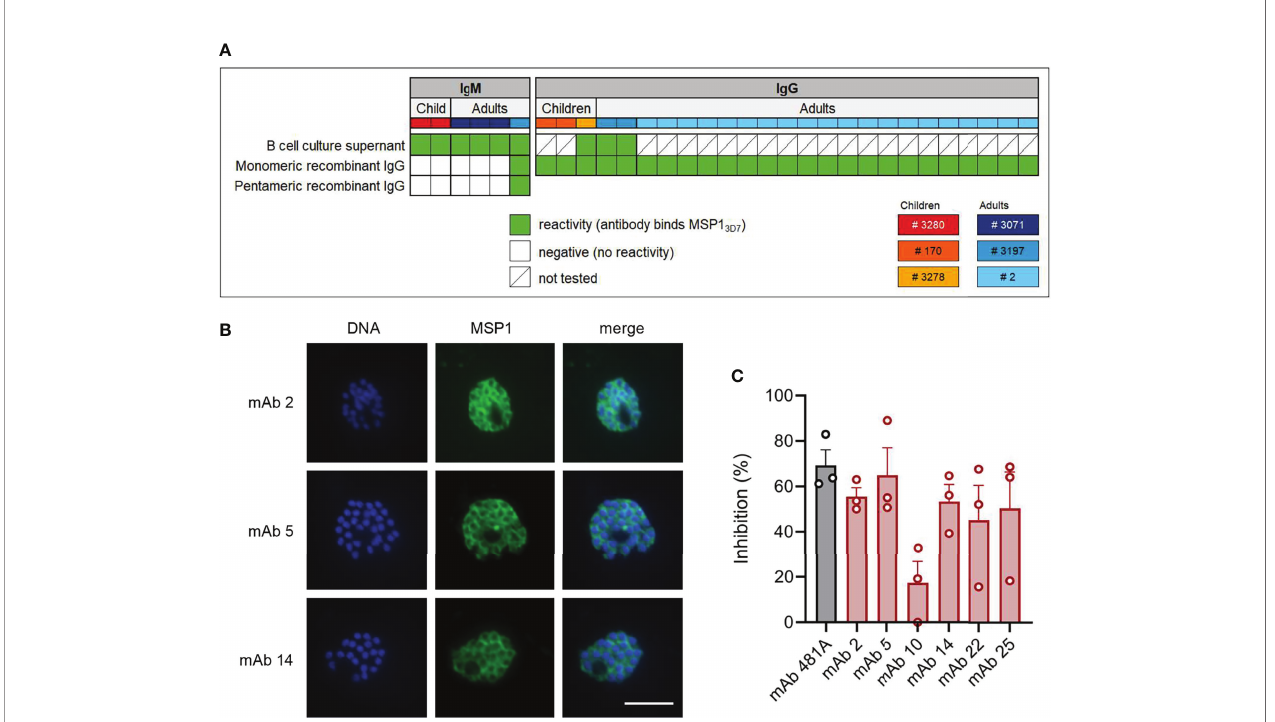
FIGURE 3 | PfMSP1 FL-3D7 reactivity and growth inhibitory activity of anti-PfMSP1 monoclonal antibodies isolated from memory B cells. (A) PfMSP1 FL-3D7 reactivity of supernatants of clonal MBC cultures determined by ELISA or Luminex assay and reactivity of mAbs obtained from MBCs (recombinant IgG) as determined by Luminex assay. The donor from whom mAbs were isolated is color-coded in the top row. Recombinant mAbs that were derived from IgM + MBCs were tested as both monomeric and pentameric recombinant IgG. (B) Immuno fl uorescence imaging of segmented schizonts using three select mAbs isolated from MBCs of adult donor 2. At this stage, parasites consist of 16 – 32 merozoites, each with its own nucleus (shown in blue), and express PfMSP1 on the parasite cell surface (shown in green). As expected, the overlay shows that PfMSP1 does not colocalize with the nucleus, but instead forms a circular pattern around each individual merozoite. Representative images of two experiments are shown. Scale bar is 5 m m. (C) P. falciparum growth inhibition by six select mAbs isolated from adult donor 2. Inhibition was calculated relative to a negative control (antibody elution buffer that was buffer exchanged to PBS alongside puri fi ed antibodies). Results shown are the average + SEM from three independent